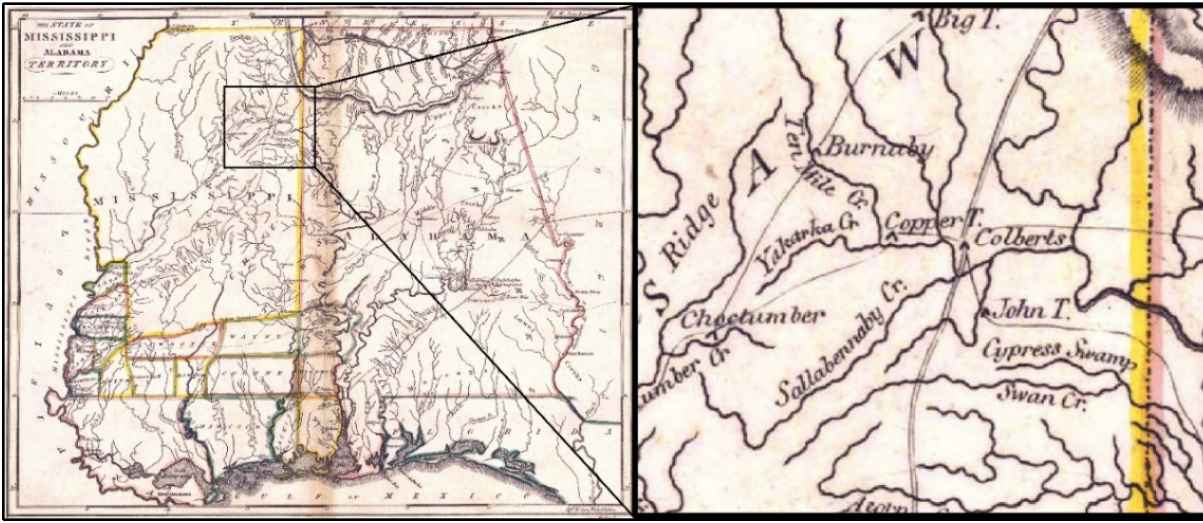
Figure 2. 1814 map of Mississippi and Alabama [22] showing “Colberts” near modern-day Tupelo where several trade paths meet (center of inset map).